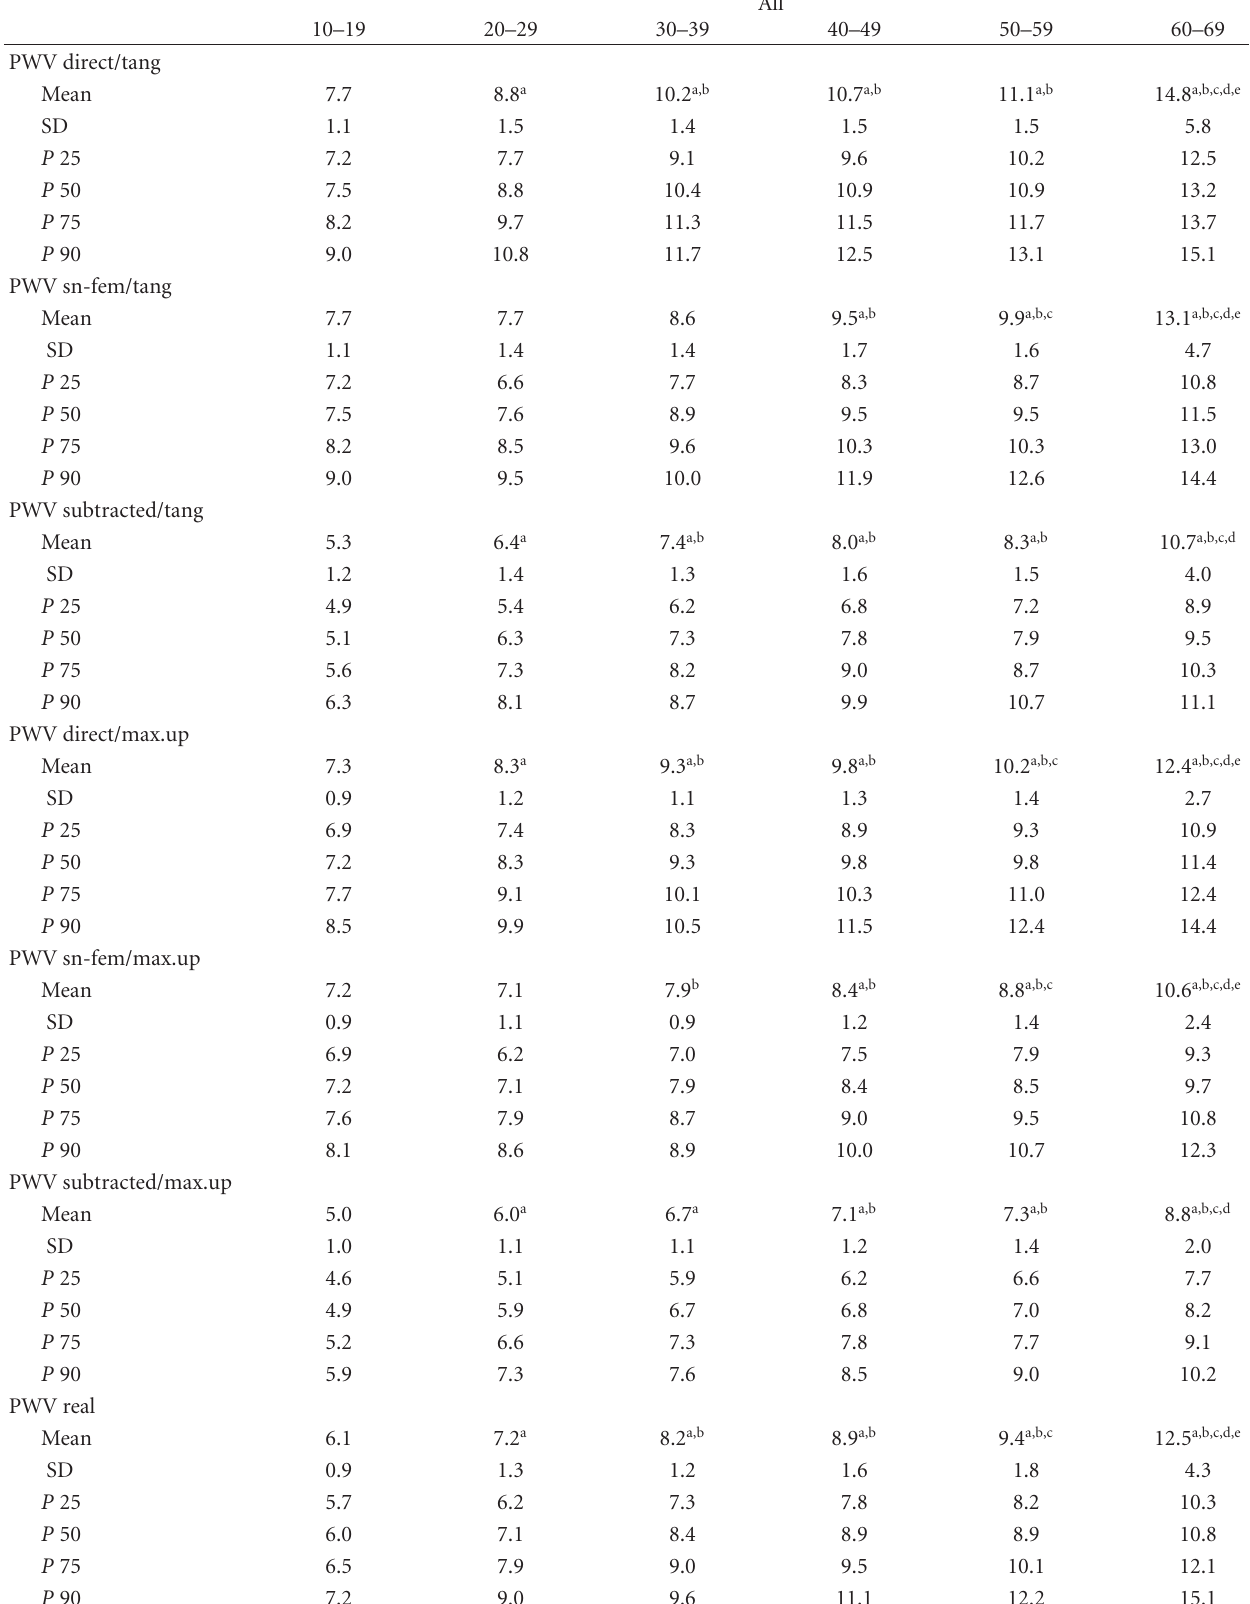
Table 2: PWV levels (reference